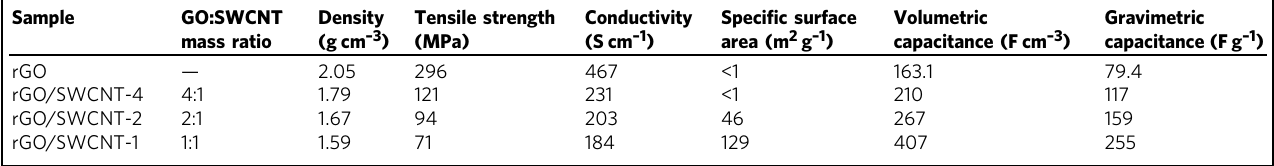
Table 1 Properties of rGO/SWCNT hybrid fi lms synthesized with different mass ratio of GO to SWCNT